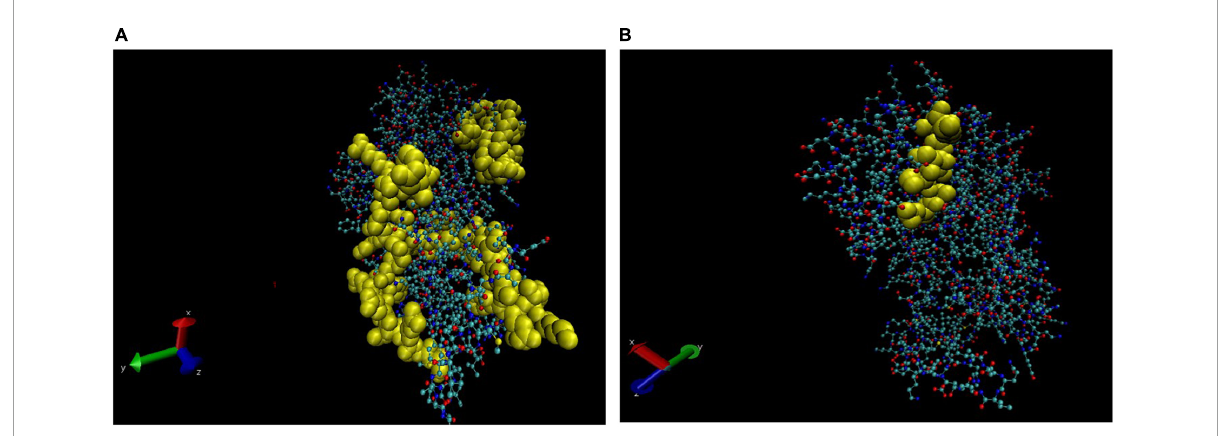
FIGURE4 Three-dimensional (3D) structure of alpha-1 antitrypsin (AAT). The B cell epitopes (BCEs) are highlighted in yellow (A,B) .